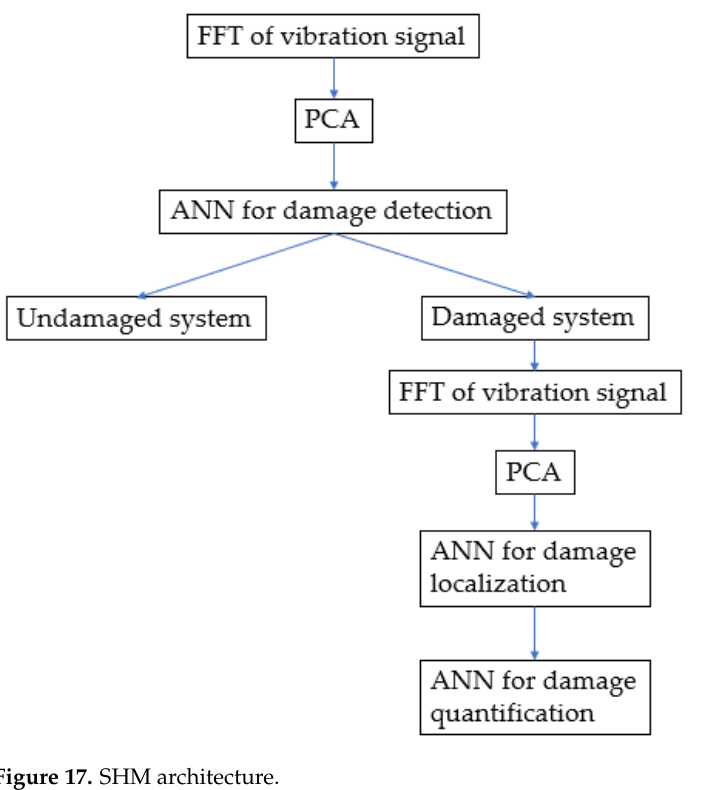
Figure 17. SHM architecture. Table 3. Training dataset